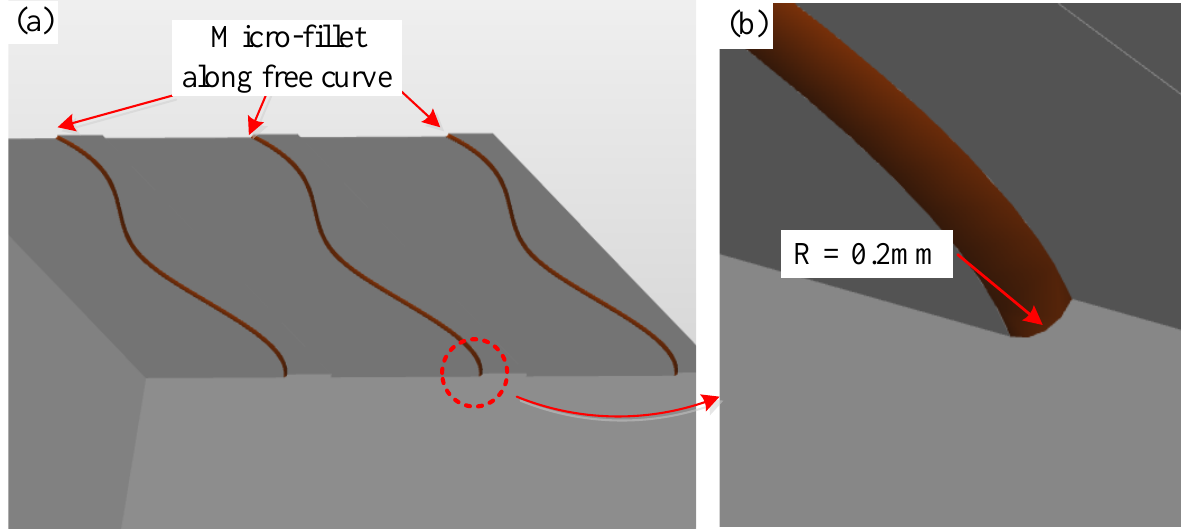
Figure 4. Simplified micro-fillet shape.